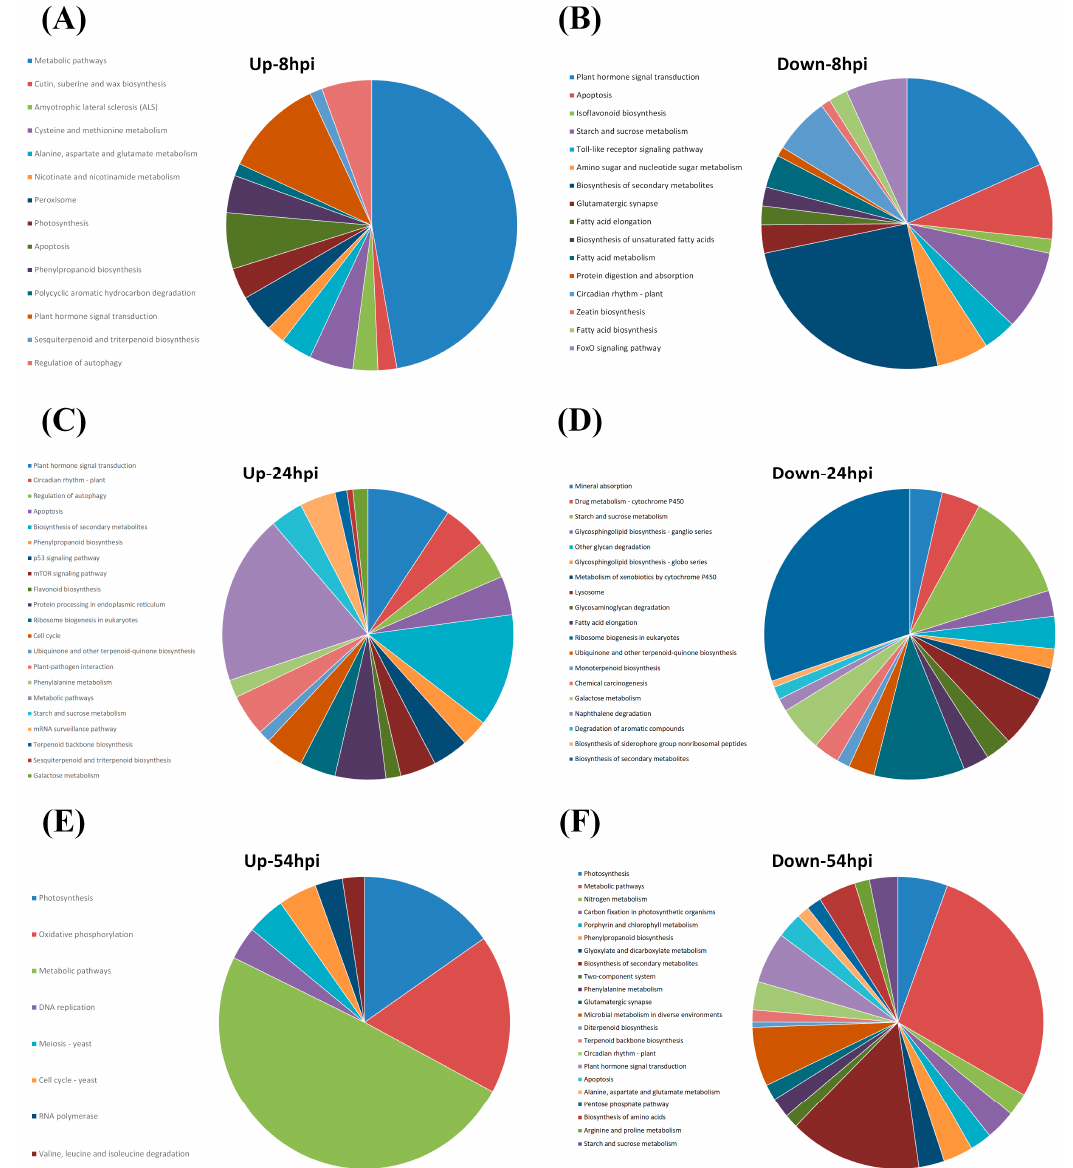
Figure 2. Relative distribution of enriched pathways in soybean plants (L29 Rsv3 -cultivar) infected with SMV-G5H at different time points. Enriched pathways in the upregulated DEGs in G5H-infected plants at 8 hpi ( A ), 24 hpi ( C ), and 54 hpi ( E ). Enriched pathway in the downregulated DEGs in G5H-infected plants at 8 hpi ( B ), 24 hpi ( D ), and 54 hpi ( F ).